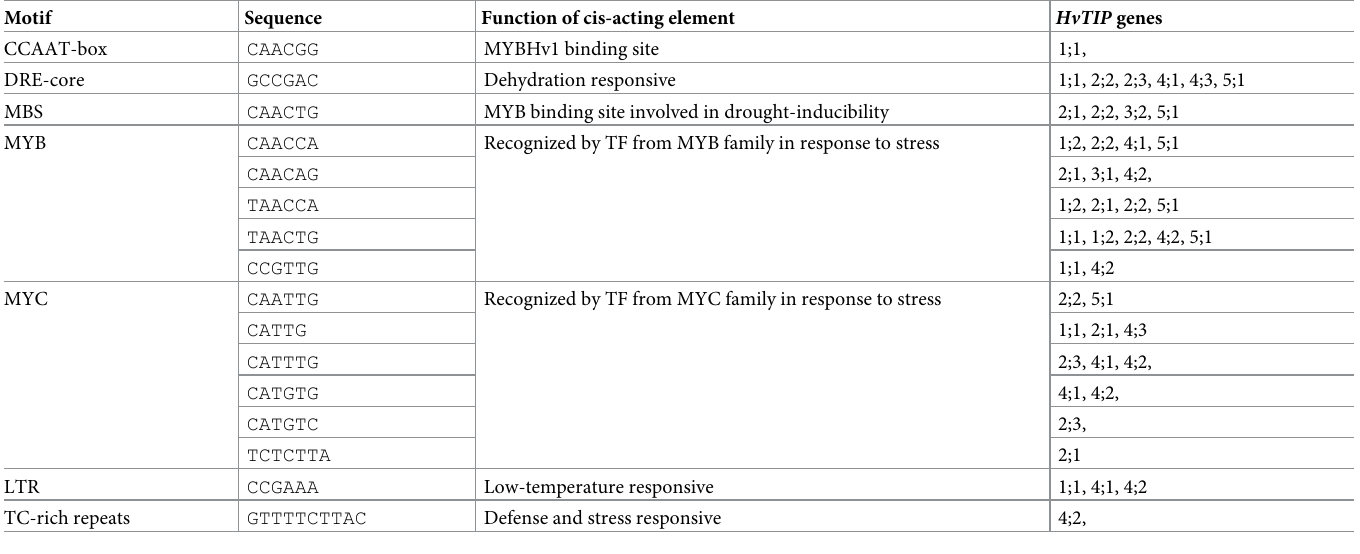
Table 2. Stress-related cis -acting elements found in the HvTIP promoters.